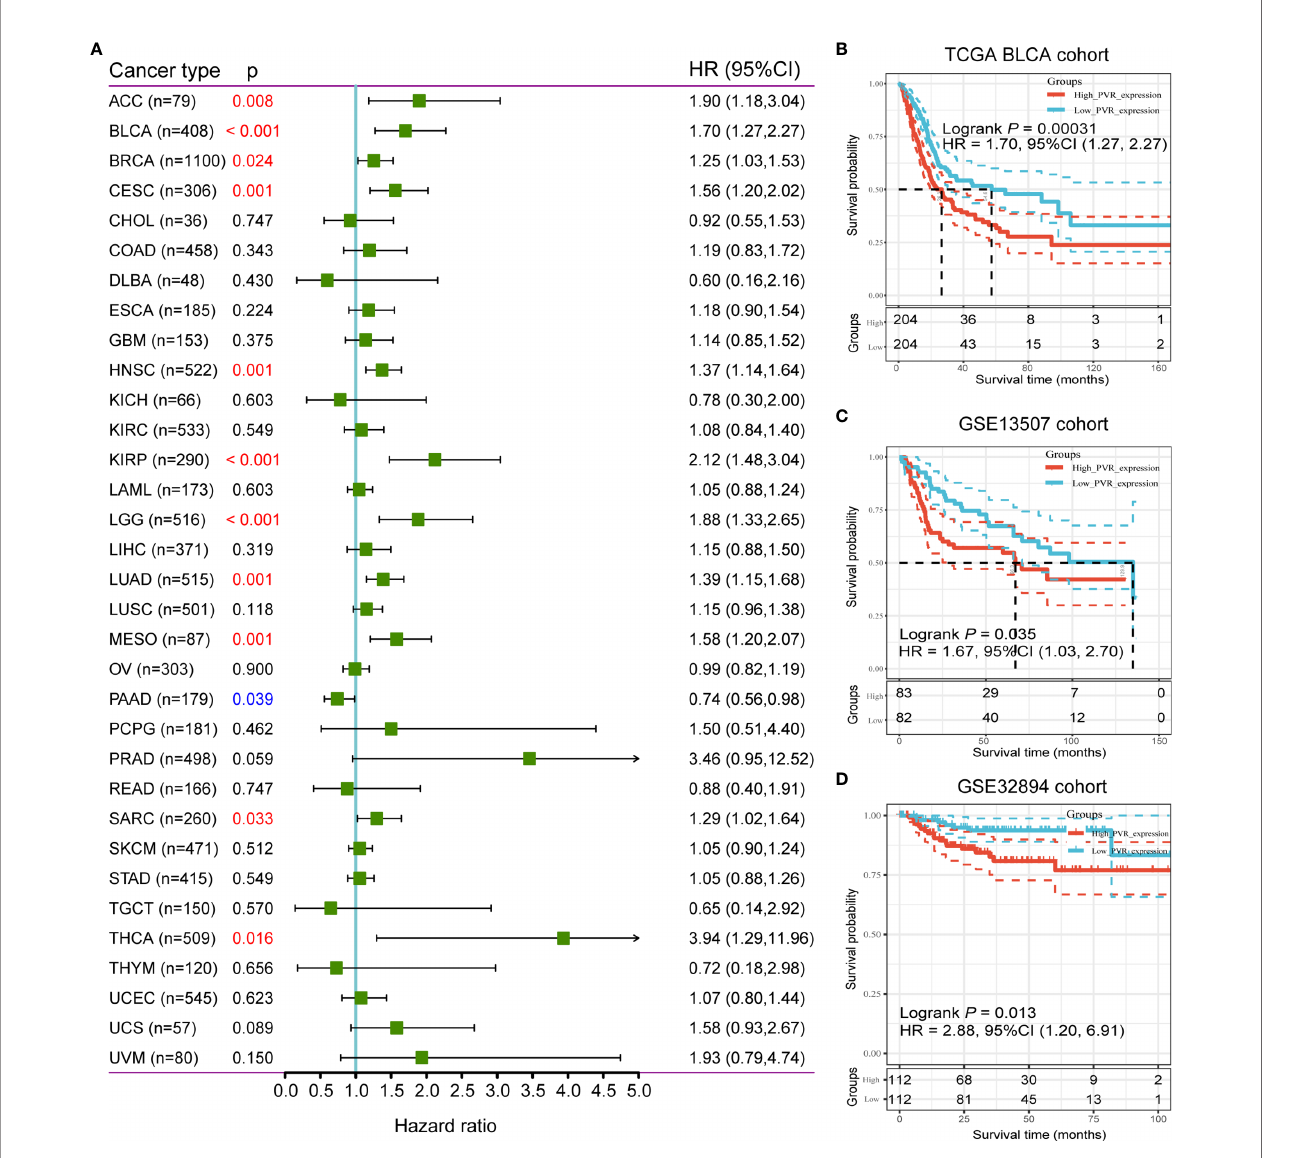
FIGURE 2 | Survival analysis comparing PVR high and PVR low groups in cancers. (A) Relationship between PVR expression and patient overall survival across 33 cancer types in TCGA database. (B – D) Kaplan-Meier survival curves based on PVR expression in TCGA BLCA, GSE13507, and GSE32894